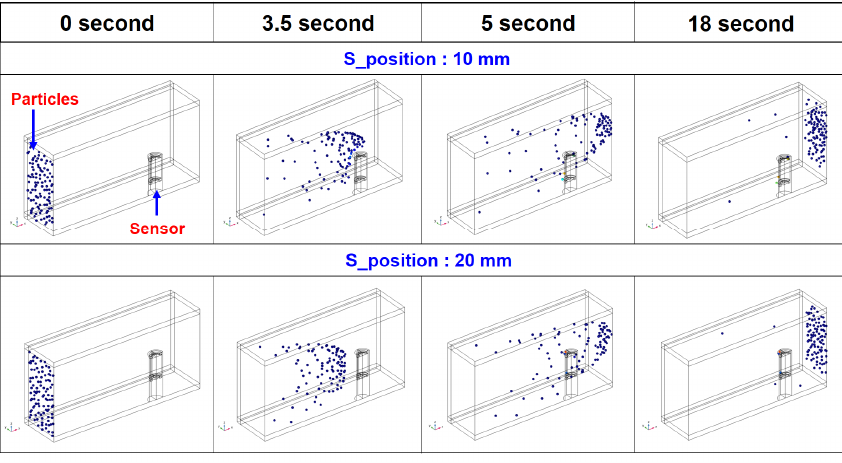
Figure 17. Particle trajectories with time.